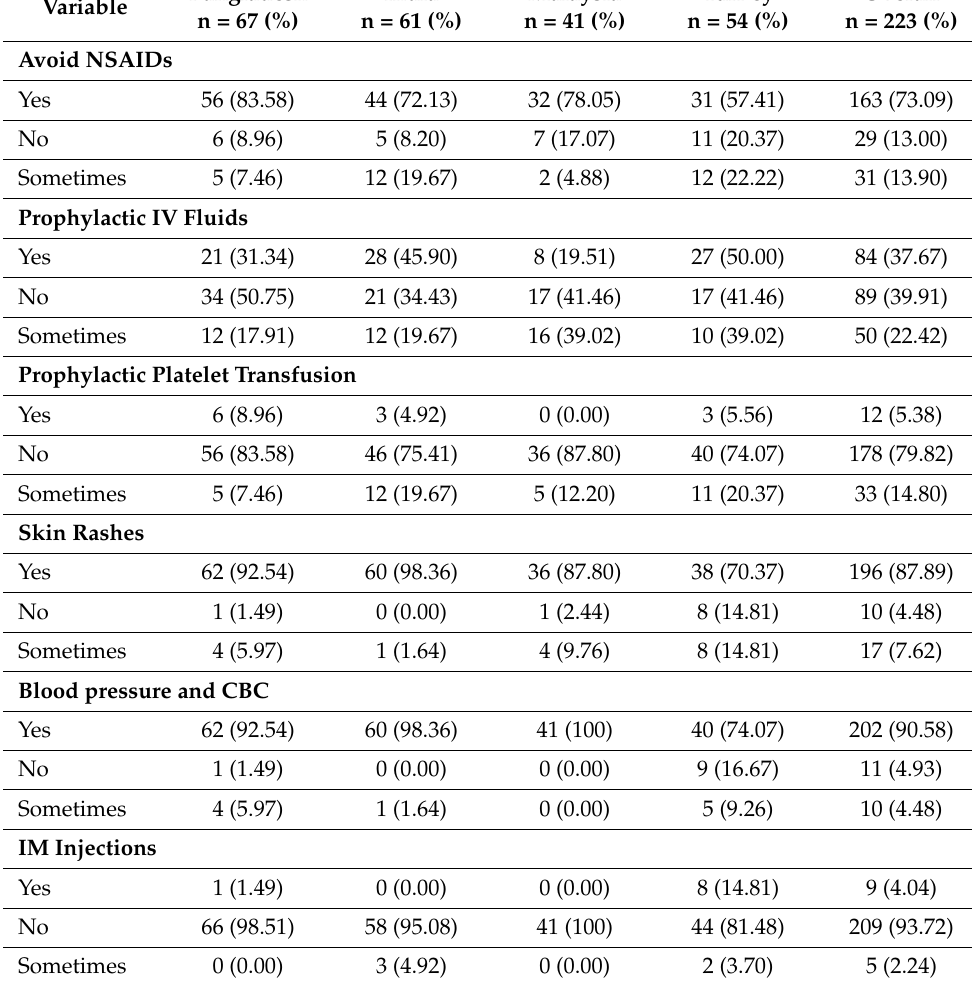
Table 3. Dengue practices of physicians by country of